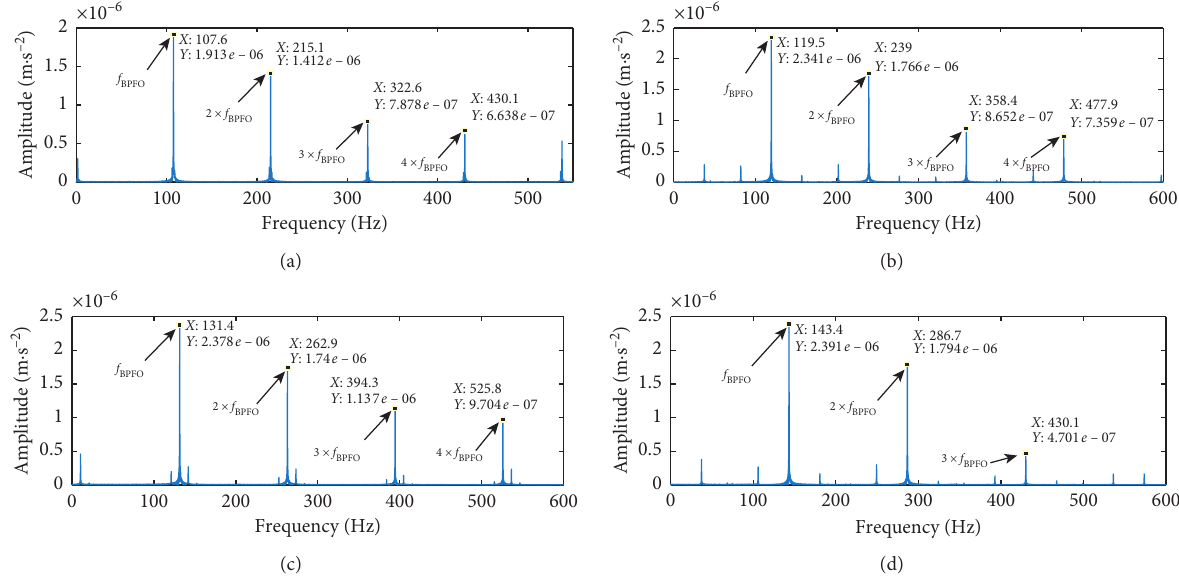
Figure 20: Simulated signals in frequency domain under different rotation speeds when load is 500N and defect size is 0.014 inches: (a) 1800rpm, (b) 2000rpm, (c) 2200rpm, and (d) 2400rpm.